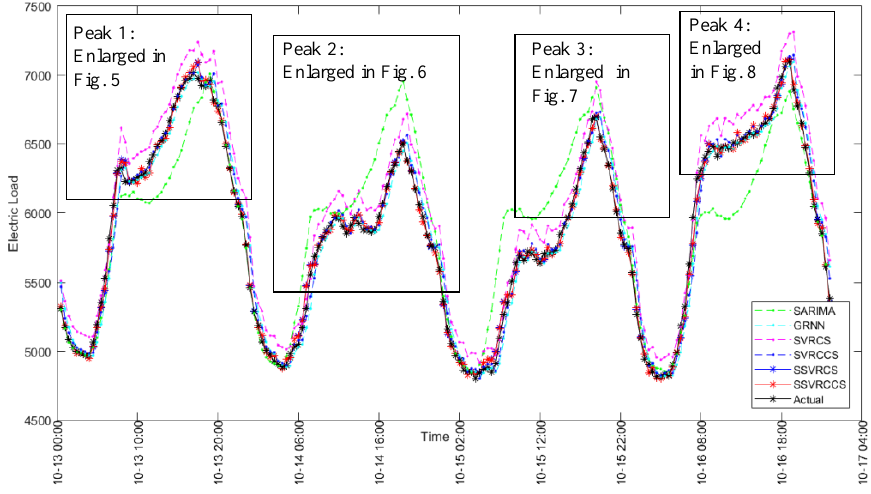
The forecasting comparison curves of six models, including the SARIMA ((cid:2877),(cid:2869),(cid:2876))×((cid:2872),(cid:2869),(cid:2872)) , GRNN ( σ =